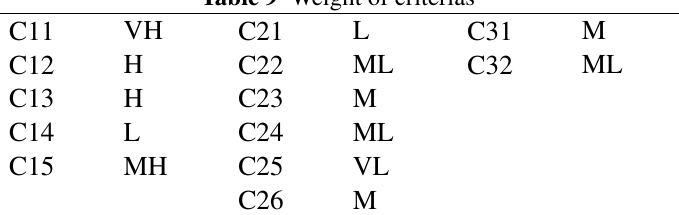
Table 9 Weight of